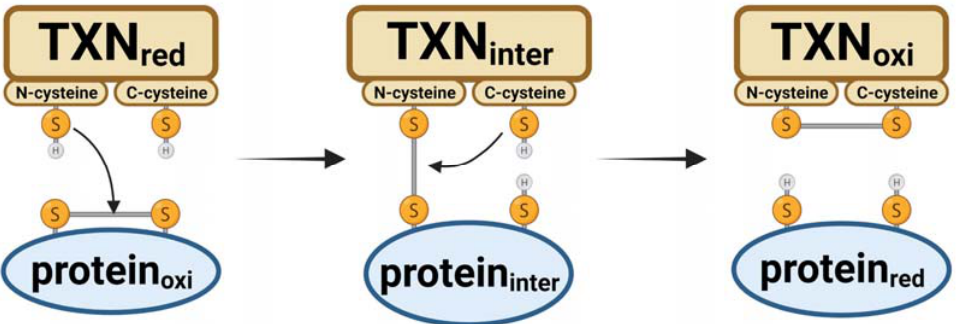
Figure 3. Mechanism of thioredoxin reaction to reduce oxidized proteins. The reduced (red) form of thioredoxin (TXN) can transfer two electrons and two protons to convert an oxidized protein’s di- sul fi de to a dithiol. This reaction involves cysteines at positions 32 (N-terminus) and 35 (C-terminus) of thioredoxin that execute a bimolecular nucleophilic substitution to transfer electrons to the sub- strate protein. The process ends with an oxidized (oxi) thioredoxin. Inter = intermediate reactant. S- S = oxidized form. SH = reduced form.